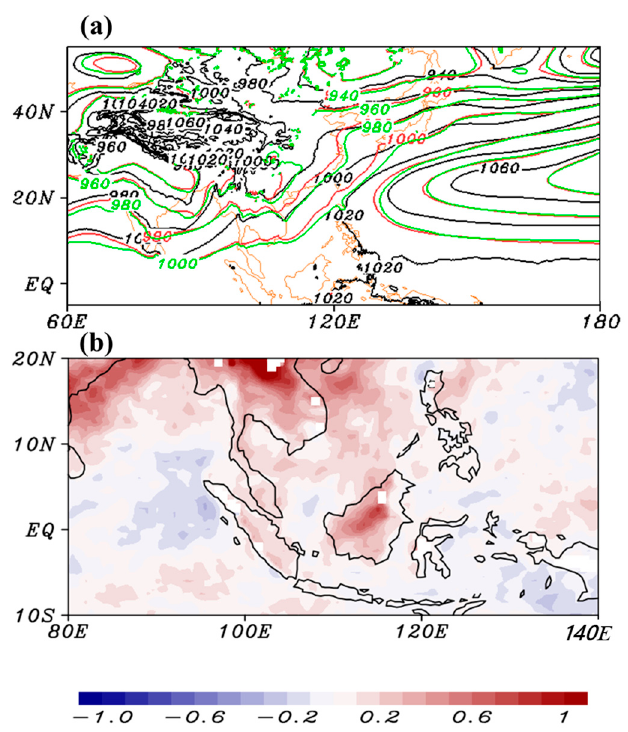
Figure 7. ( a ) 900-hPa geopotential height (m) averaged over 96~120 h forecast based on 32 daily cases from 0000 UTC 15 May 2020 to 0000 UTC 15 June 2020 from the CTRL (red contour) and EXP (green contour) experiments. The Black contour in ( a ) is the result obtained from ERA5 reanalysis data. ( b ) the difference in temperature (K) for 96~120 h forecast between EXP and CTRL